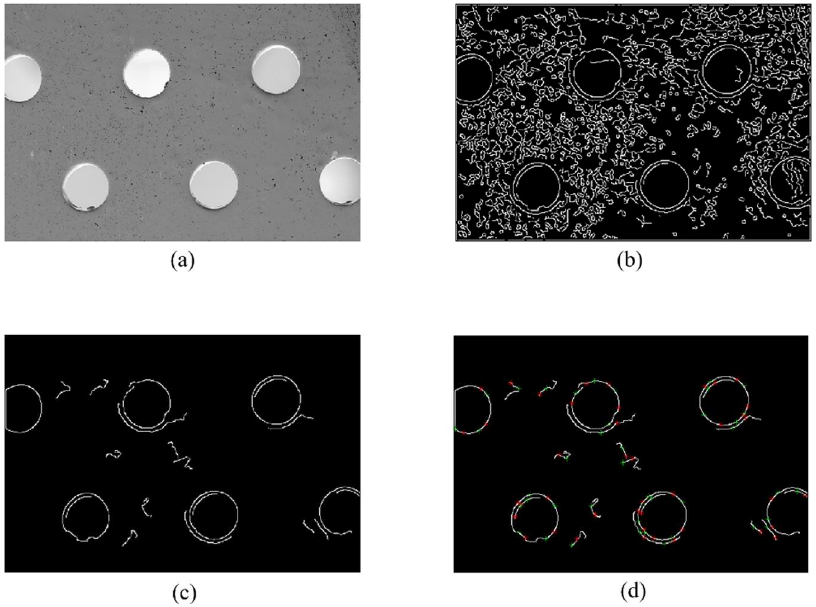
Figure 5. The intermediate results of our procedure are shown: ( a ) the original image; ( b ) the result of adaptive canny edge extraction; ( c ) the image after we have performed useless arc removal; ( d ) the information points we selected and used. ‘*’ and ‘+’ mark the information points.